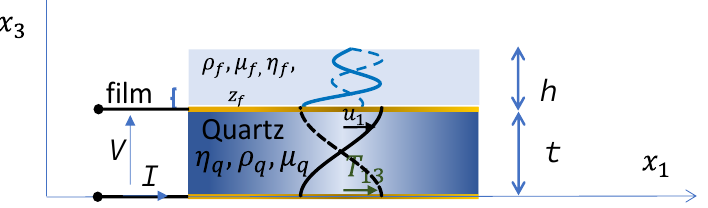
Figure 3. Electromechanical behavior of a loaded quartz with a homogeneous film layer on one of its electrode surfaces.